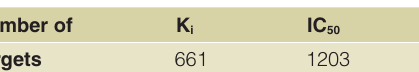
Table 1. Data sets.